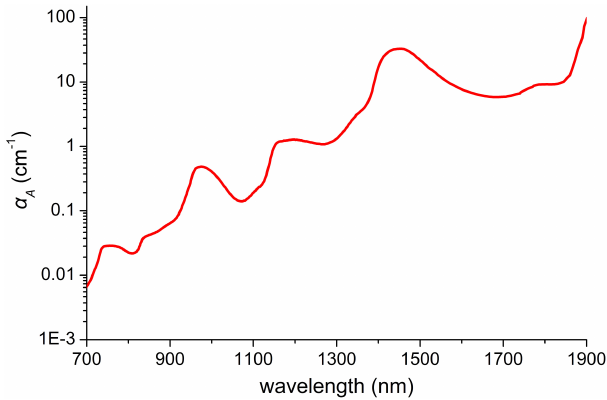
Fig. 1. Water absorption coe±cient at di®erent wavelengths.